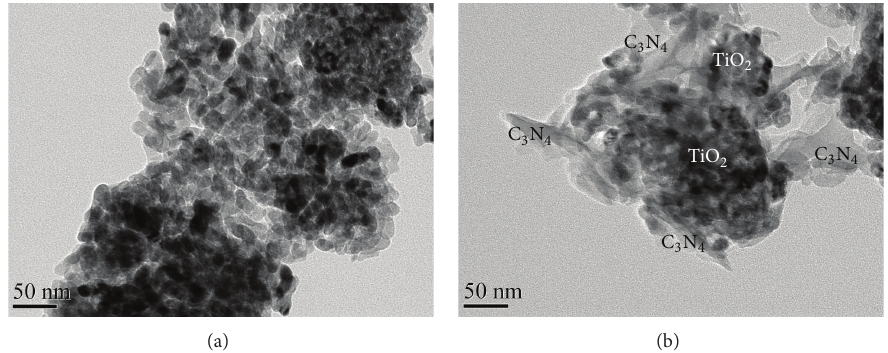
Figure 2: TEM images of pure TiO 2 (a) and g-C 3 N 4 /TiO 2 nanocomposites sample obtained under 450 ∘ C (b).